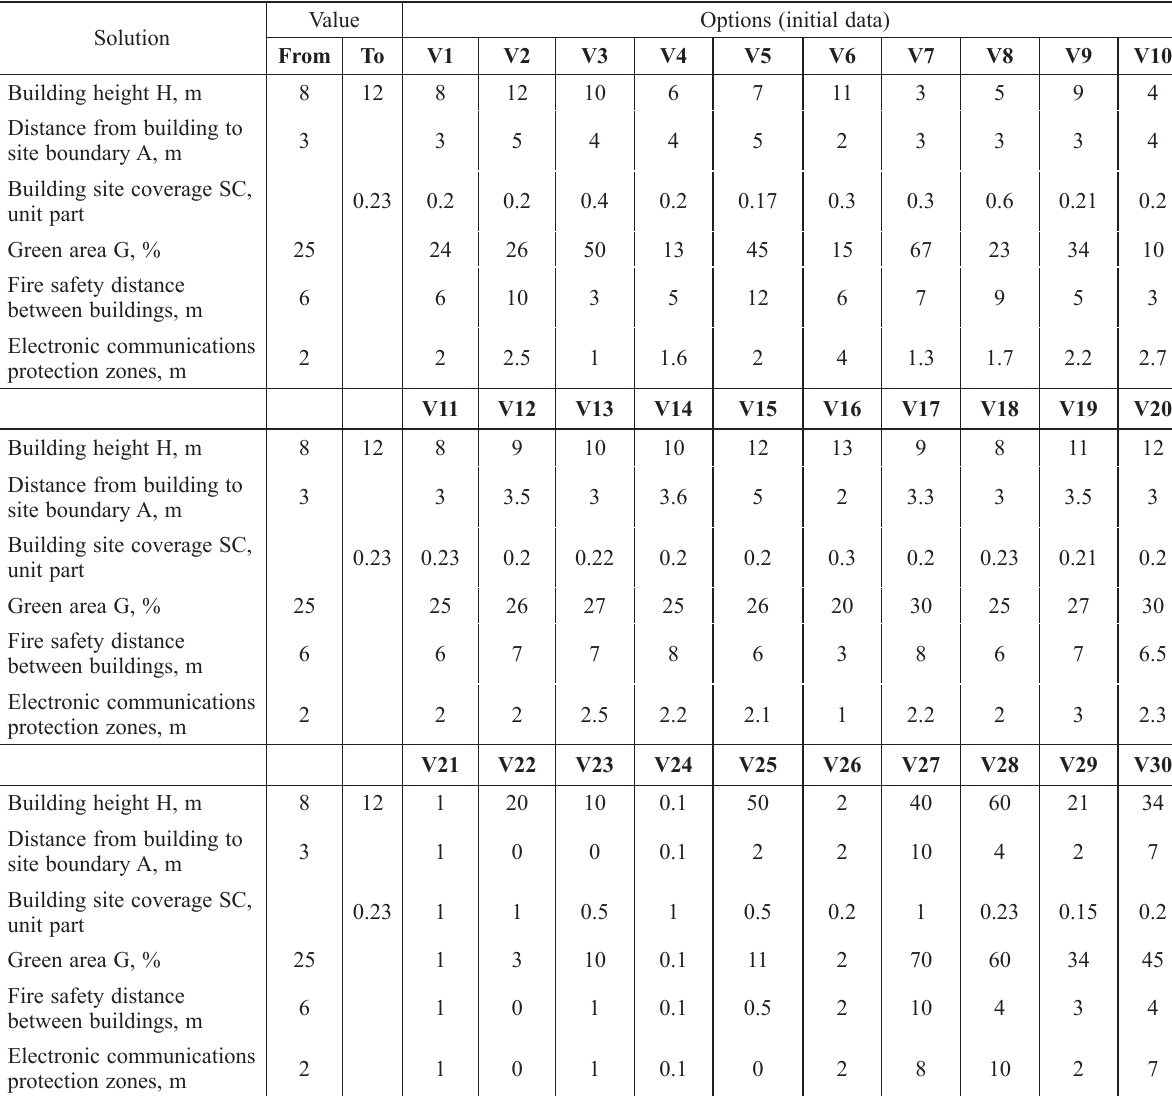
Table 1. Initial data Solution